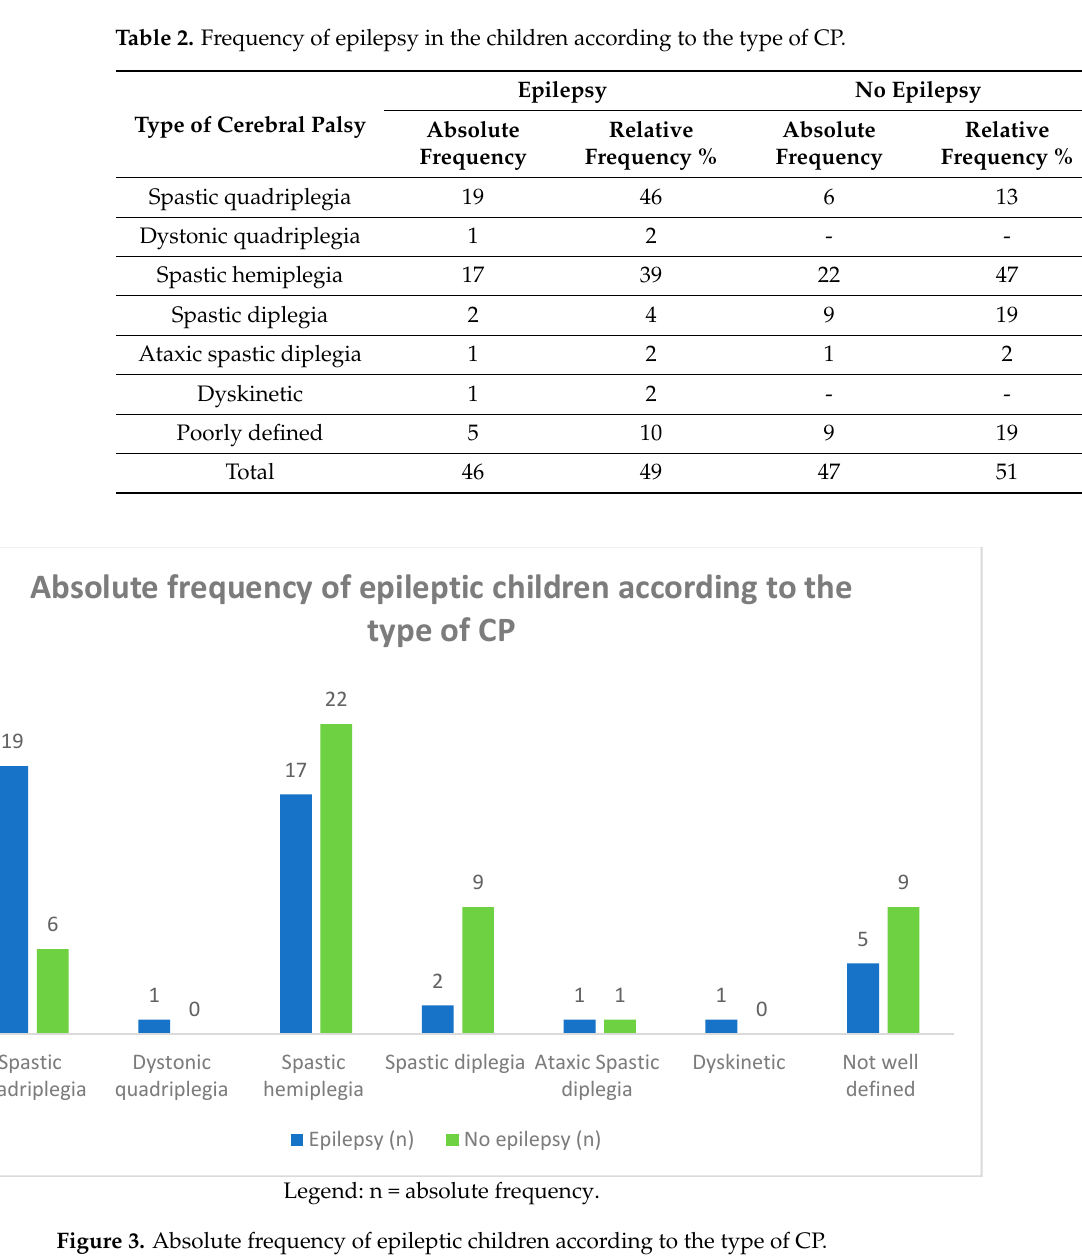
Legend: % = relevance frequency. Figure 4 . Relevance frequency of epileptic children according to the type of CP. Furthermore, in the comparison between children with spastic quadriple- gia and those with spastic hemiplegia, the frequency of epilepsy was significantly higher in the former (46% vs. 39%; p = 0.02). As in the comparison with the chil- dren with spastic diplegia, the frequency was significantly higher in the quadri- plegic children (46% vs. 4%; p = 0.002). Instead, no statistically significant differ- ence was found in the comparison between hemiplegic and diplegic children.